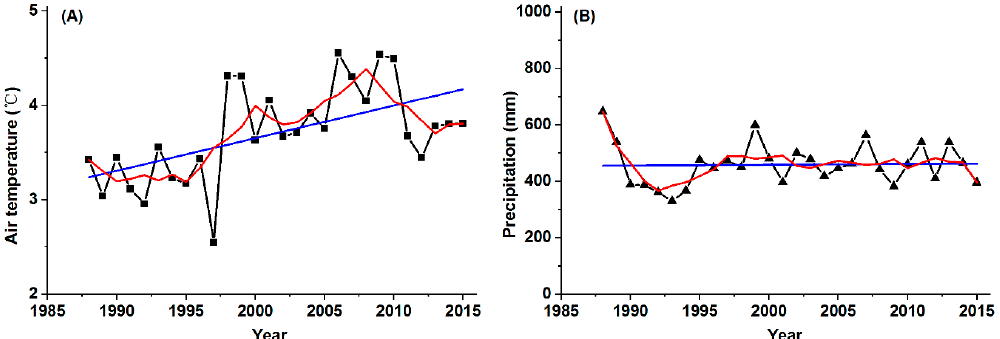
Figure 10. Air temperature ( A ) and annual precipitation ( B ) changes in the central Himalayas observed from the nearest meteorological stations between 1988 and 2015. The blue line represents the linear regression. The red curve is the 5-year moving average.